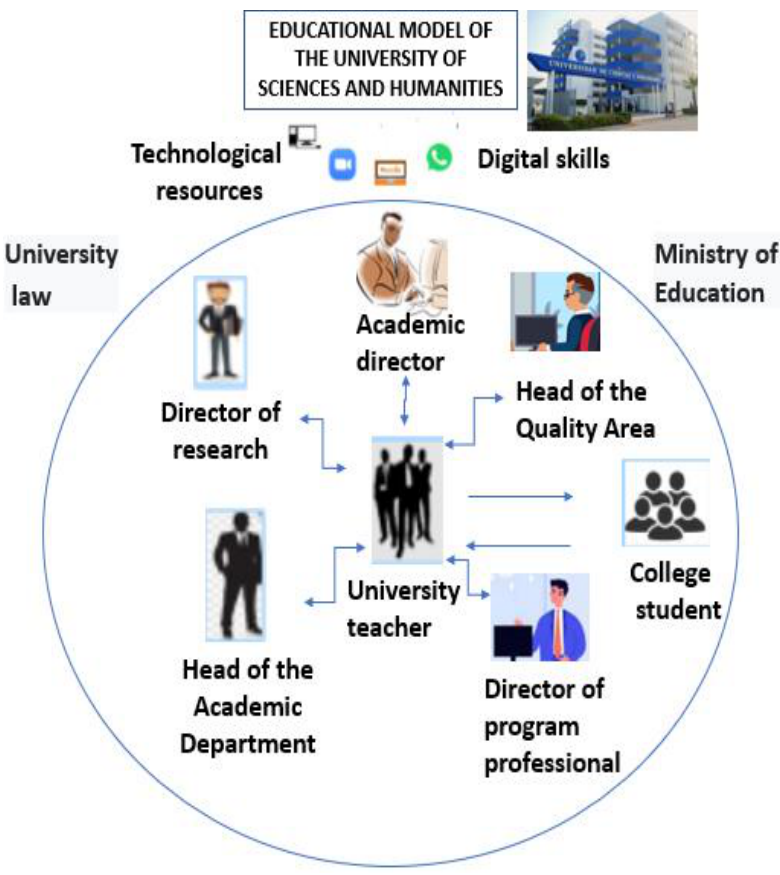
Fig. 1. Proposed approach as an holistic